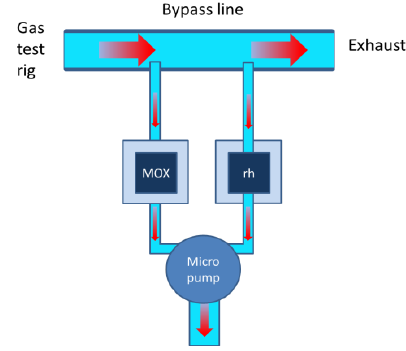
Figure 9. Self-testable EMRS sensor array featuring MOX gas sensor and a capacitive humidity (rh) reference sensor.